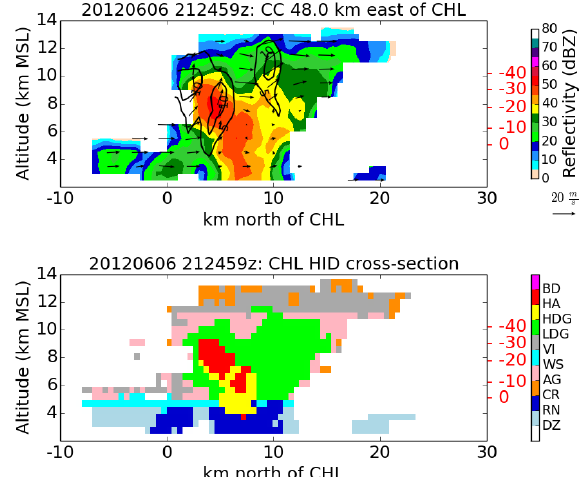
Figure 2. Two-panel plot of a south–north cross-section through the main updraft core of the 6 June southern storm at 21:25. (a) CSU- CHILL radar reflectivity (dBZ; colored contours), winds (arrows, scale at right), and updraft (ms − 1 ; black contours) in the cross- section. (b) results of the polarimetric radar-based hydrometeor identification (HID) using CSU-CHILL polarimetric variables. The regions are identified as BD (big drops/melting hail), HA (Hail), HDG (high-density graupel), LDG (low-density graupel), VI (ver- tical ice), WS (wet snow), AG (aggregates), CR (ice crystals), RN (rain), and DR (drizzle). Temperatures ( ◦ C) derived from a proxim- ity sounding are indicated by the red text on the right-hand vertical axis.